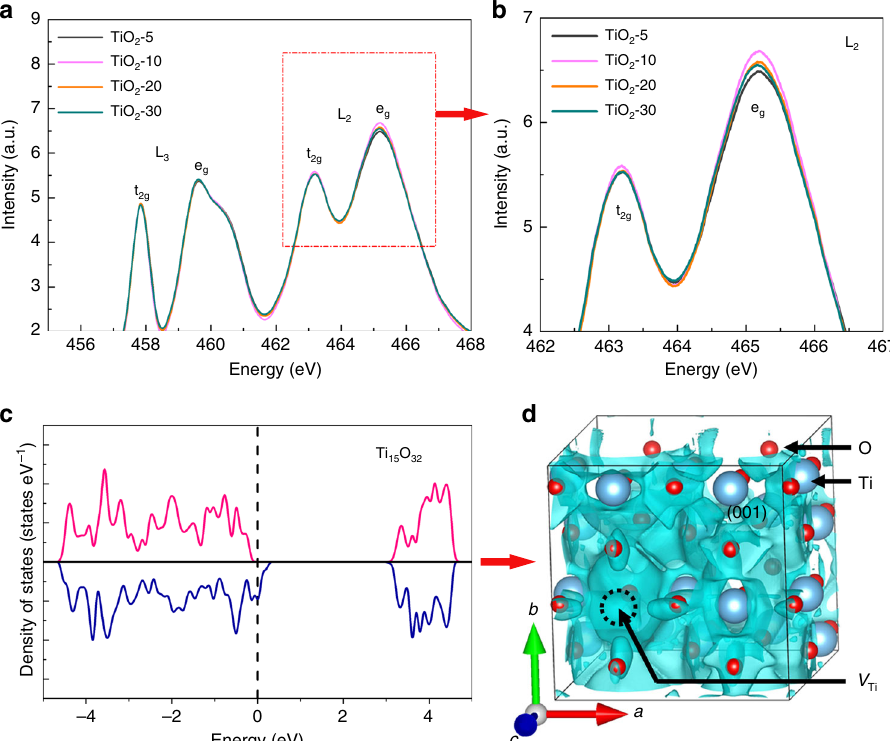
Fig. 3 Spin-dependent electronic structures of metal-defected TiO 2 . a , b Ti L-edge and high-resolution L 2 XAS spectra. c Calculated total density of states (DOS) and d (001)-Planar 3D spatial distributions of spin polarization (with the energy interval of [ E F -0.2 eV, E F ]) of metal-defected Ti 15 O 32 model (6.25% V fi c iso-surface SSP value for d is − Ti ). The speci